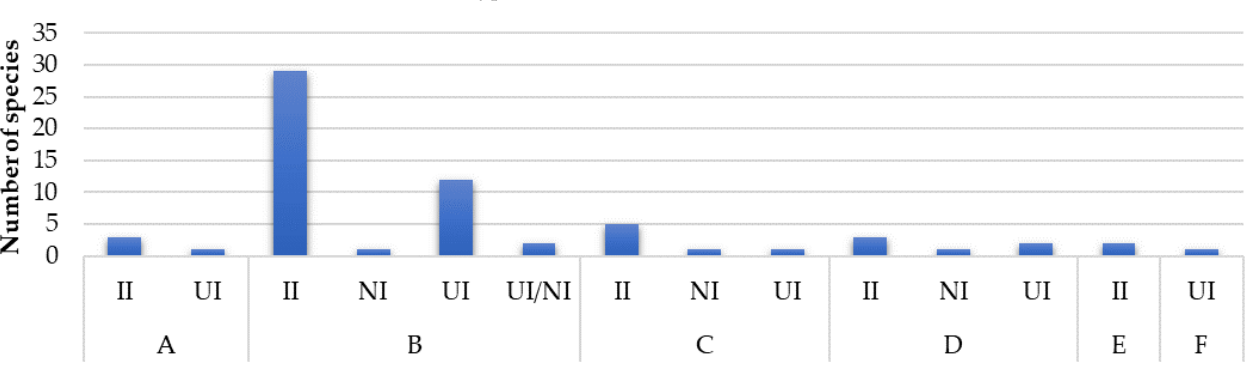
Figure 3. Habitat types of IAS.